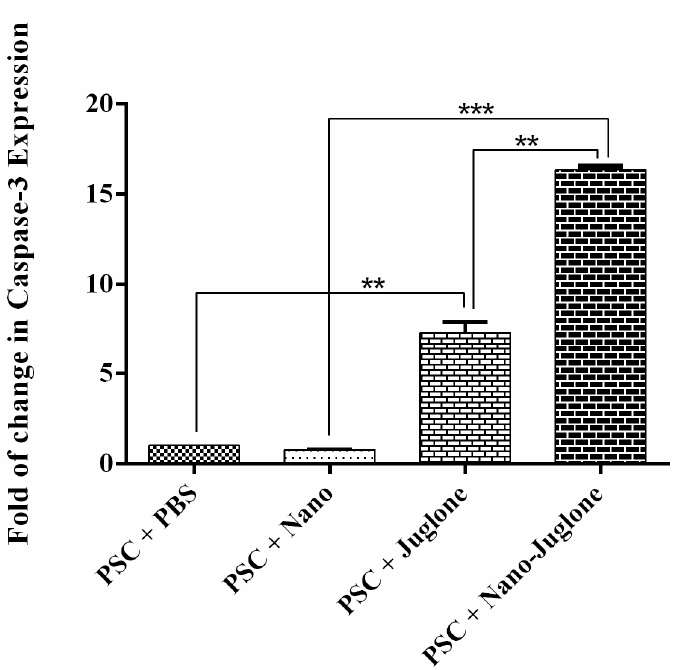
Figure 3. Caspase-3 gene expression determined by real-time PCR in PSCs treated with PBS (negative control), PSCs treated with nanoliposomes (negative control), PSCs treated with juglone, and PSCs treated with juglone nanoliposomes. The bar graph indicates the mean ± standard deviation. Caspase-3 mRNA expression was higher in both PSCs treated with juglone nanoliposomes than in control groups (** p < 0.01, *** p < 0.001).